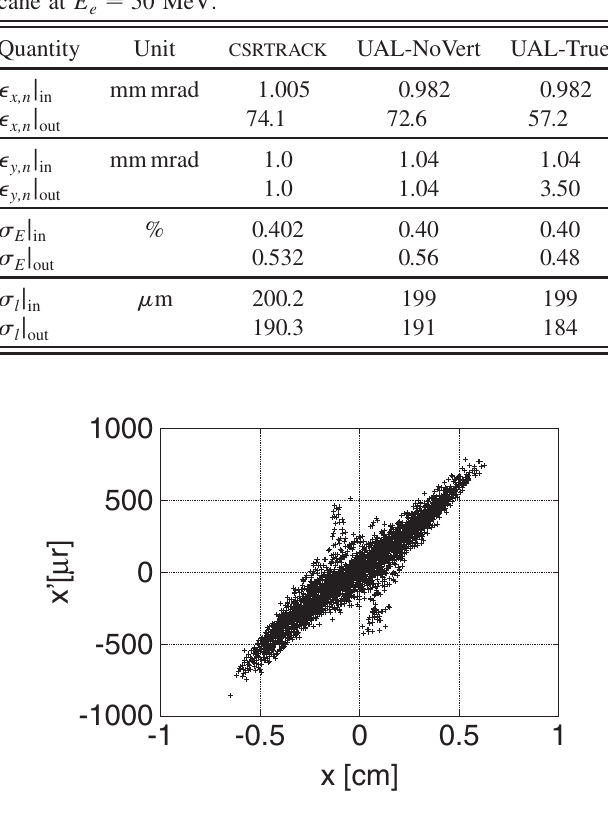
FIG. 11. Vertical-force-suppressed horizontal phase space out- put from UAL. The horizontal axis gives horizontal particle coordinates with the same scale as in Fig. 12. For this plot the number of macroparticles was N p ¼ 3200